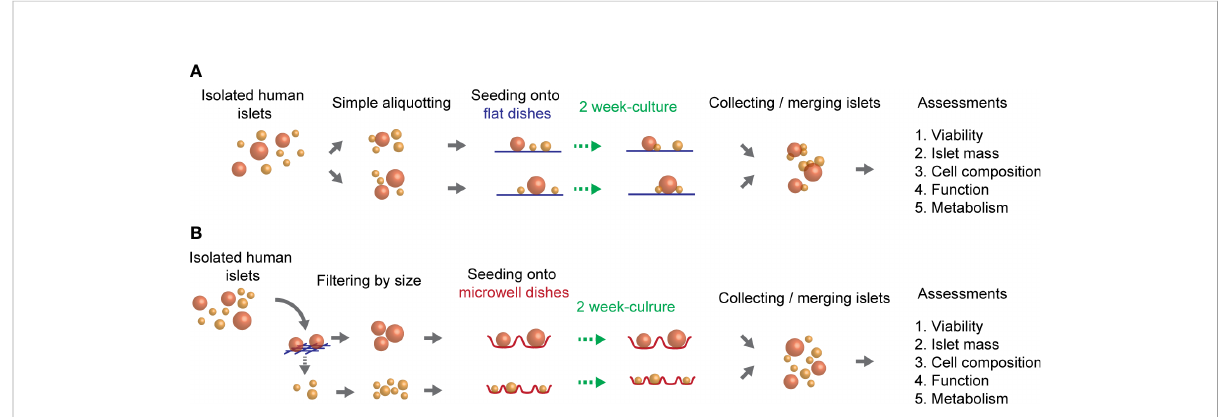
FIGURE 1 Overview of the culture method of human islets. Isolated human islets were seeded on two different types of culture dishes ( fl at or microwell) and cultured for two weeks. (A) A schematic of culture method using fl at-bottomed, conventional dishes. (B) A schematic of culture method using microwell-bottomed